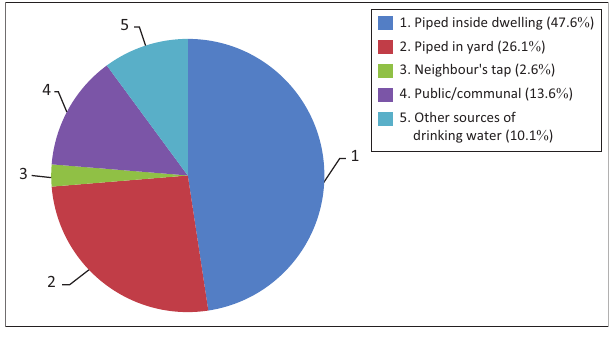
FIGURE 1: Main source of drinking water for households in South Africa.